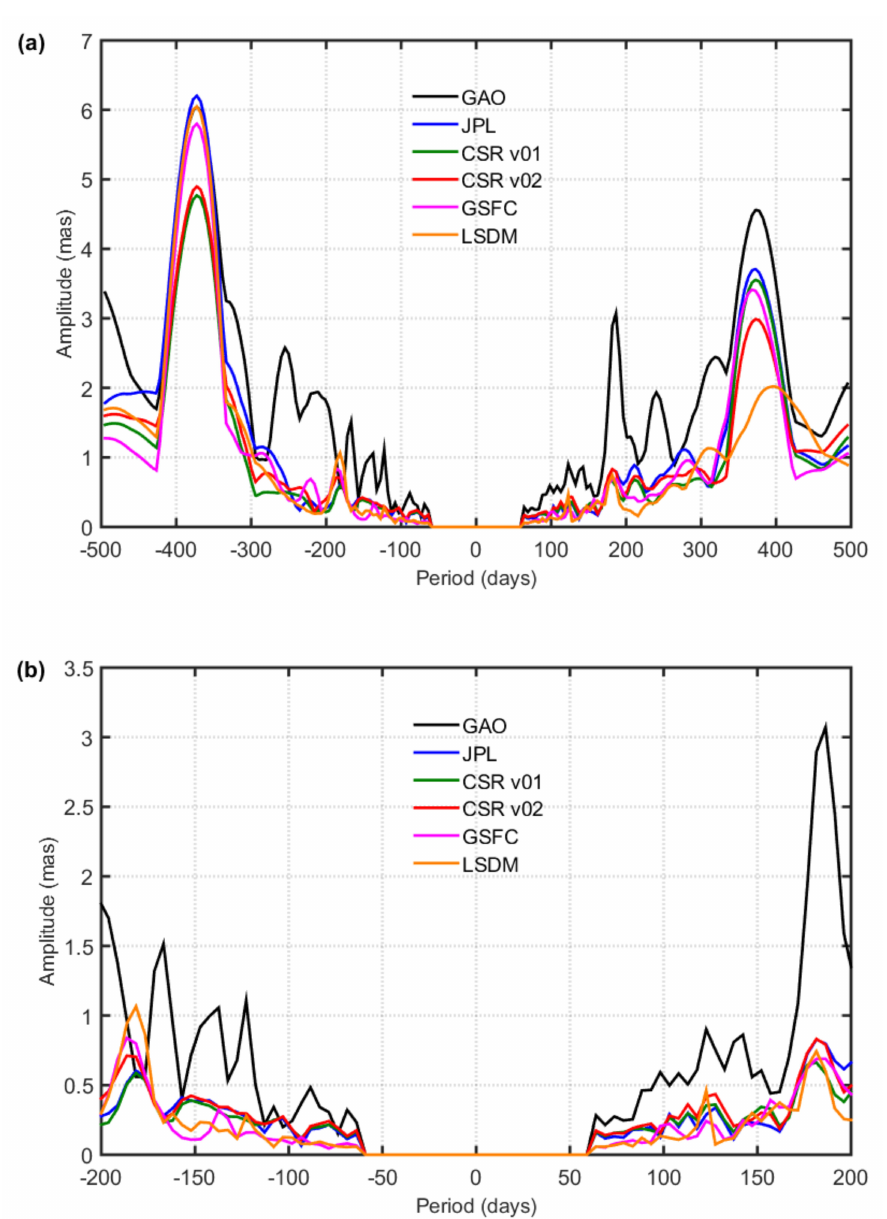
Figure 3. Amplitude spectra of the GAO, GRACE-based HAM/CAM, and LSDM-based HAM computed in a broad band with ( a ) a 60–500-day cut-off and ( b ) 60–200-day cut-off. The minus time period on the plot indicates retrograde terms, while plus time period indicates prograde terms. Note that the periods shorter than 60 days are not considered, because all series were monthly sampled and their Nyquist frequency is about 6 cycles per year, which corresponds to the periods of about 60